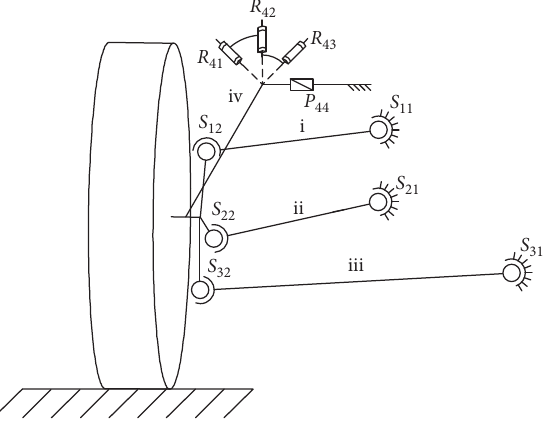
Figure 2: Sketch of the topology of the integrated E-type multilink suspension wheel-side drive system with (i) the upper control arm, (ii) front-lower control arm, (iii) rear-lower control arm, and (iv) integrated trailing arm.